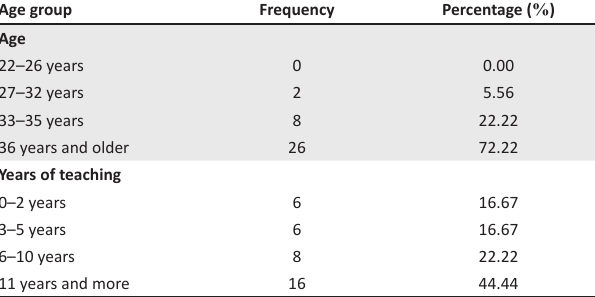
TABLE 3: Scores of participants before and after the educational session.